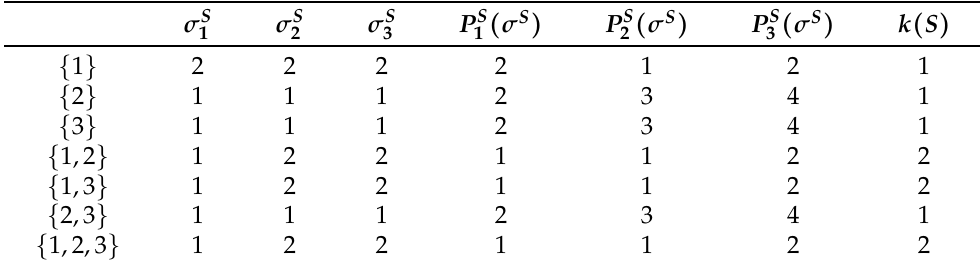
Table 4. An optimal plan for the SI-situation.